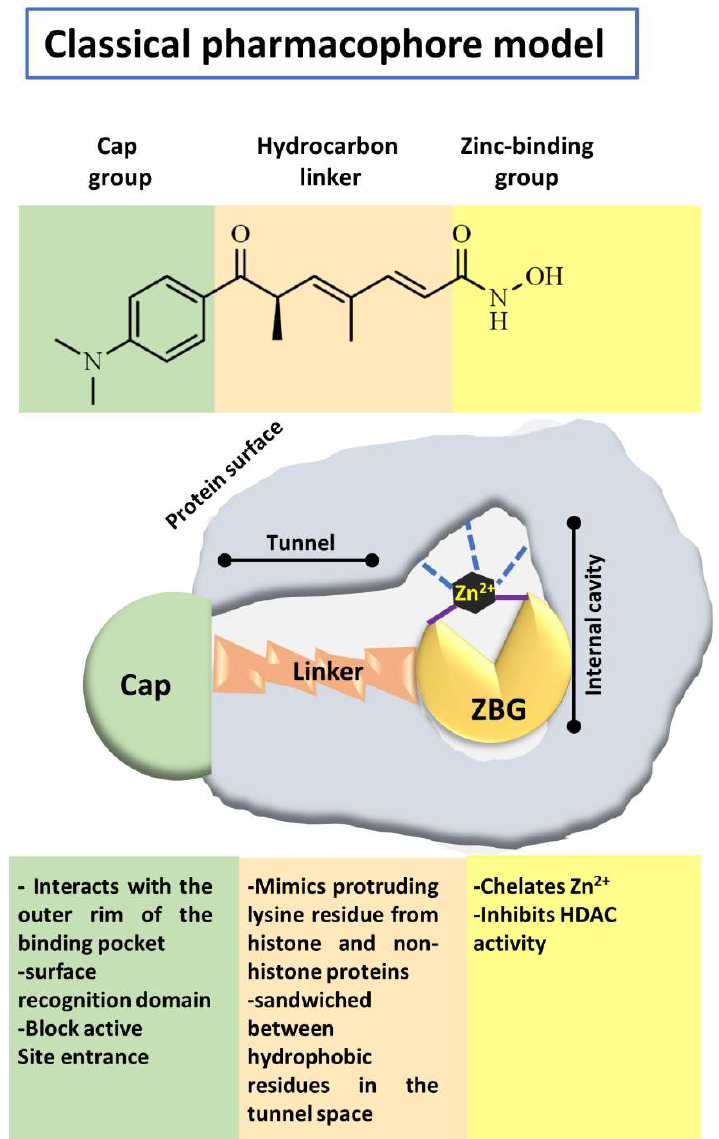
Figure 3. Classical pharmacophore model of histone deacetylases inhibitors. The classical pharma- cophore model of HDAC inhibitors (HDACi) considers three motifs and is illustrated with trichostatin A agent: a hydrophobic cap group (green) that participates in the protein recognition and interaction, a hydrocarbon linker (magenta), and a hydrophilic domain that interact with the Zinc cation (Zn 2+ ) at the enzyme active site called Zinc-binding group (ZBG) (yellow).